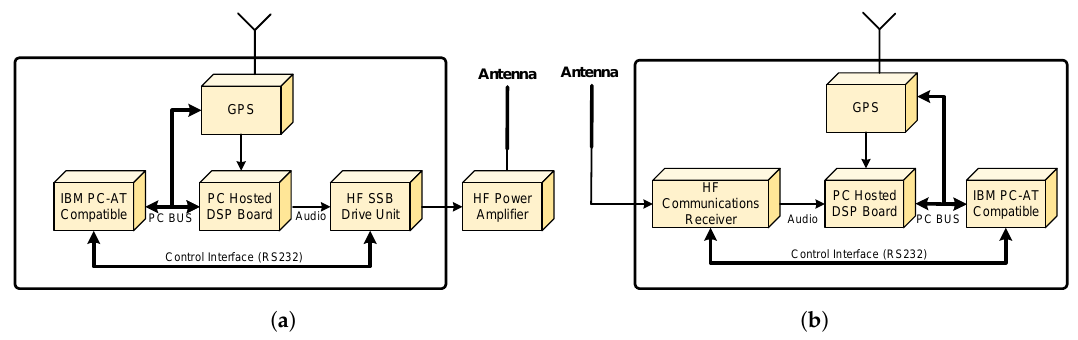
Figure 5. ( a ) Complete block diagram of the DAMSON transmitter and ( b ) Complete block diagram of the DAMSON